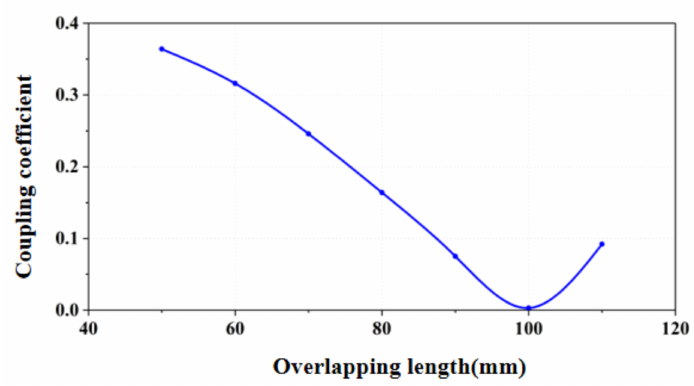
Figure 8. Variation of the coupling coefficient with the overlapping length.